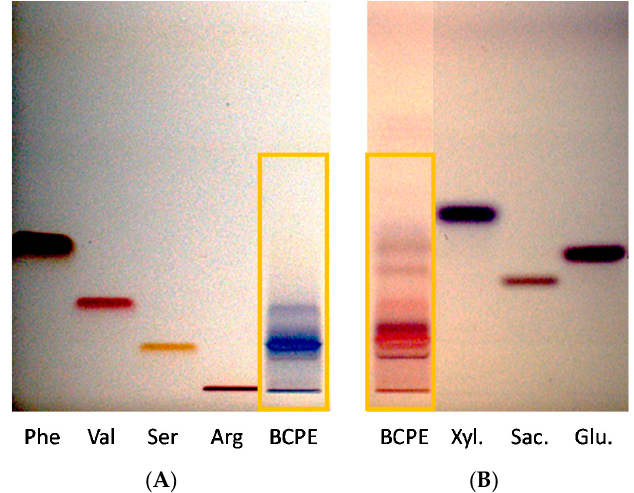
Figure 3. HPTLC plate observed under visible light to visualize amino acids ( A ) and sugars ( B ) present in the blackcurrant pomace extract (BCPE) using respectively ninhydrin and orcinol as derivatisation reagents. Tracks: Phe: phenylalanine; Val: valine; Ser: serine; Arg: arginine; Xyl.: xylose; Sac.: saccharose and Glu.: glucose.